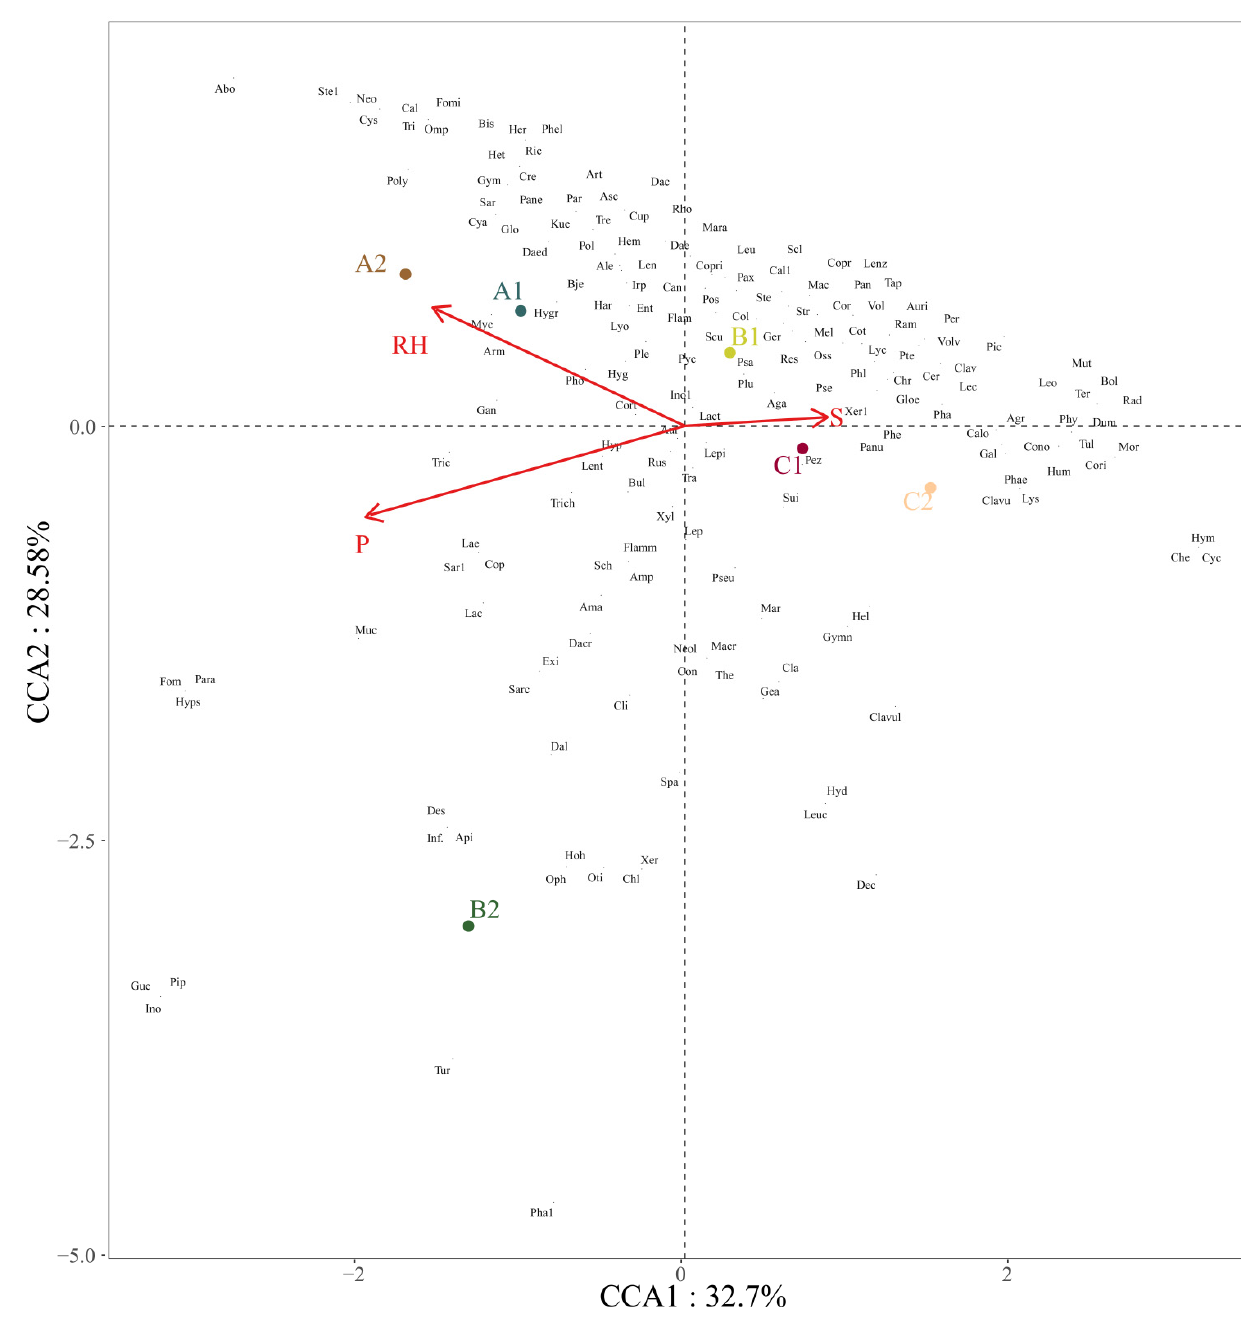
Figure 13. Canonical correspondence analysis (CCA) of the selected environmental factors and the recorded macrofungi species. All displayed environmental factors passed the most significant test ( p < 0.05); P: mean precipitation from July to September; S: mean wind speed from July to September; RH: mean humidity from July to September; A1: Quanshuidong Forest Farm; A2: Lushuihe National Forest Park; B1: Shengli River Forest Farm; B2: Longwan National Forest Park; C1: Zuojia Region; C2: Jingyuetan National Forest Park. Letters are composed of the first three- or four-letter abbreviations of the scientific name, and the corresponding words are provided in Table A2.